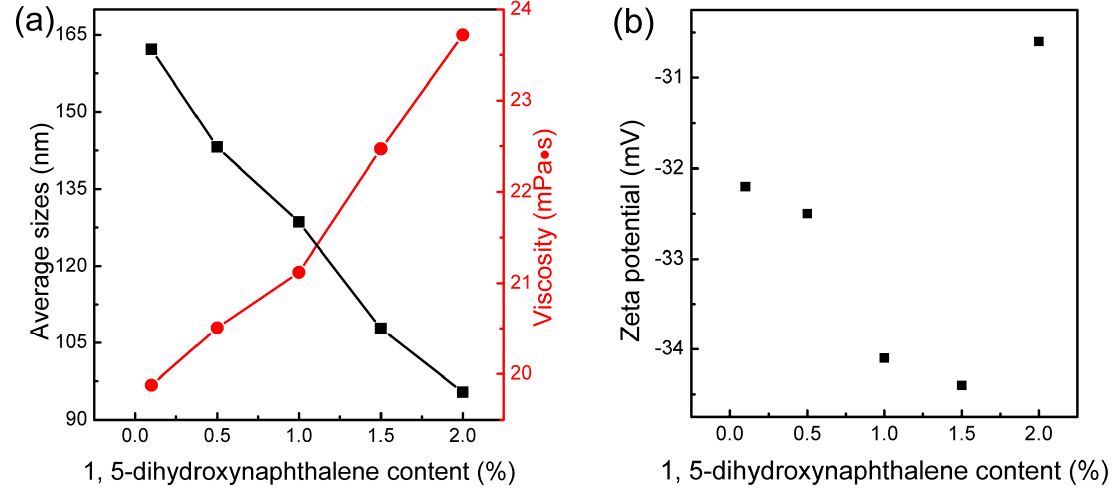
Figure 2. ( a ) Emulsion particle size, ( a ) viscosity; and, ( b ) zeta potential of NOWPUs.